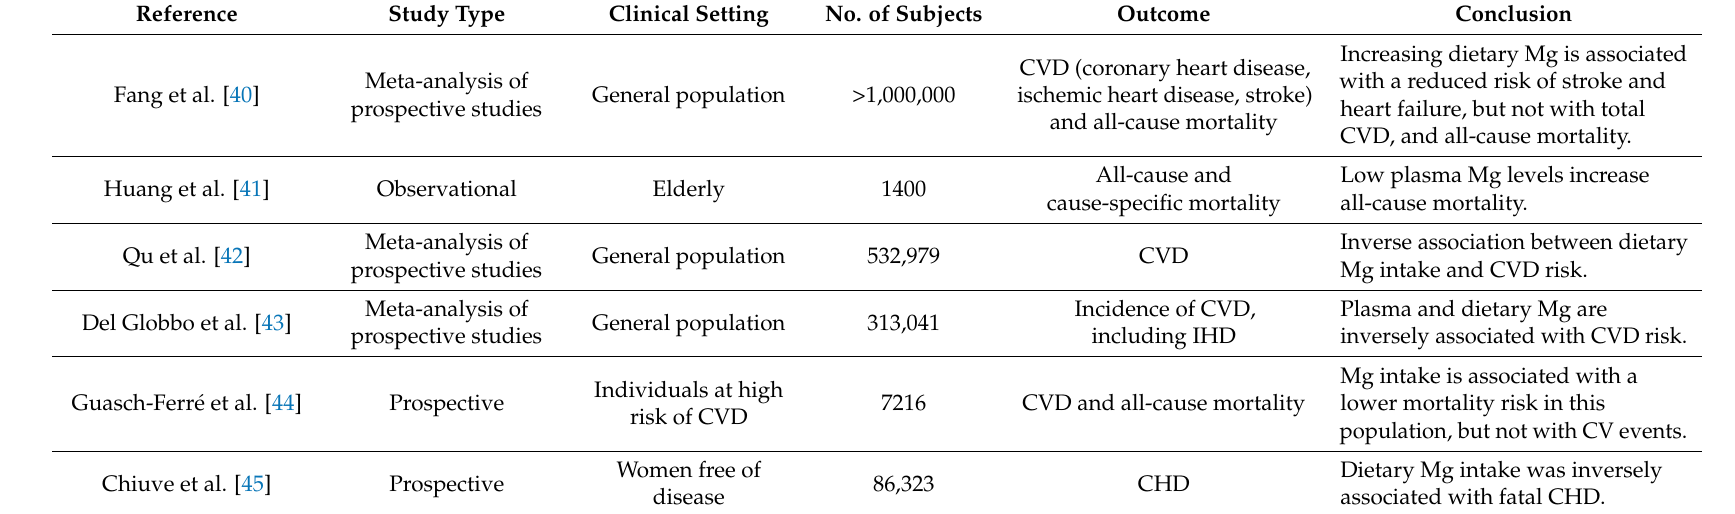
Table 1. Summary of studies evaluating the effect of magnesium on cardiovascular-related outcomes in the general